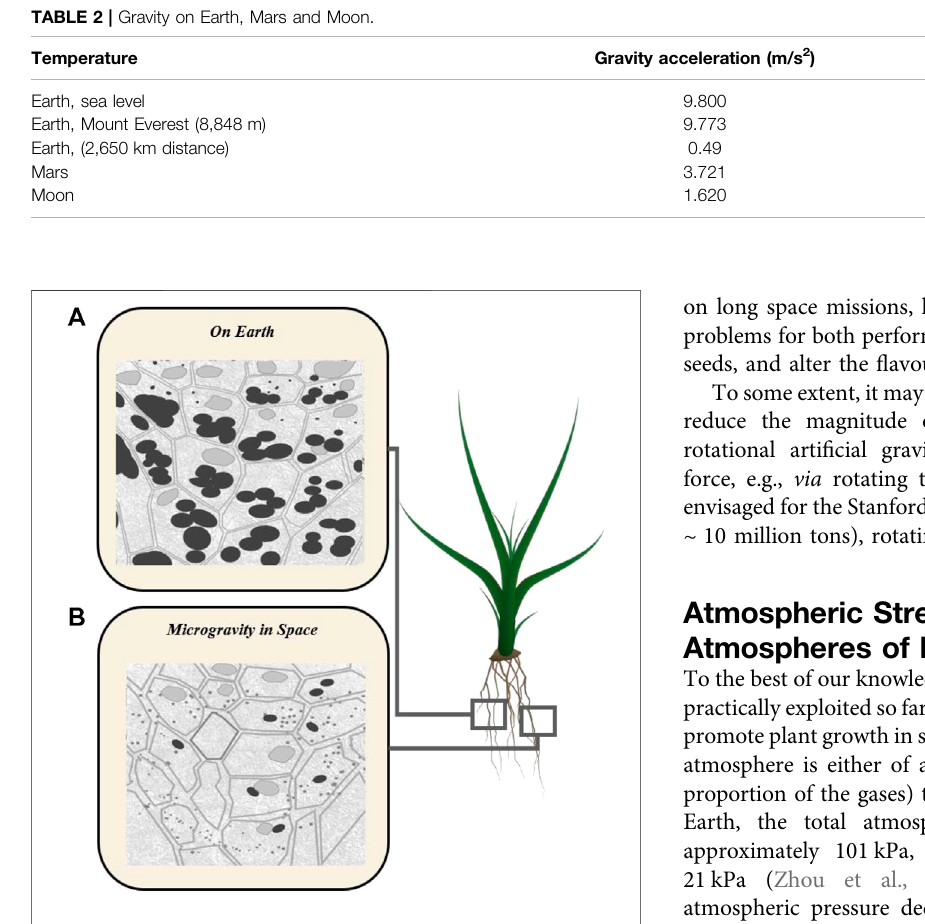
FIGURE6| Schematicofcell-internalstructure intheroottipofanormal plant with gravity-sensing Amyloplasts containing starch (A) and root tip of a starchless mutant plant under microgravity (B) (Kiss, 2000; Morita,